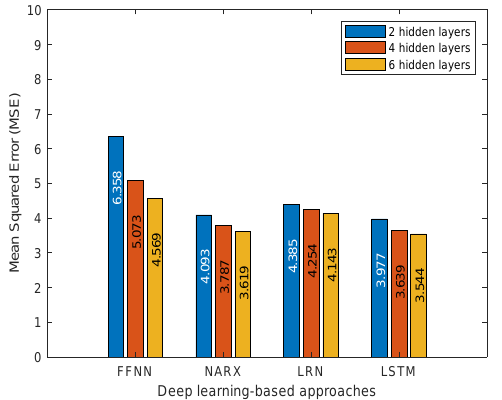
Figure 5. The MSE of deep learning-based approaches in the testing stage when the number of hidden layers is 2, 4, and 6, respectively.